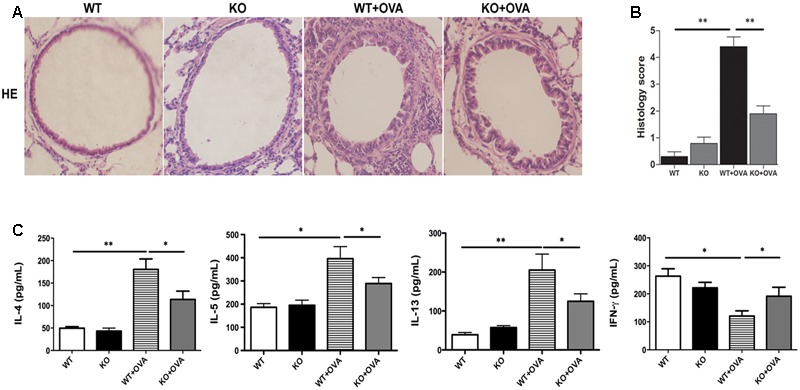
Gene deletion of KCa3.1 reduced established airway inflammation. (A) Representative images of hematoxylin and eosin-stained lung sections from WT, KO, WT + OVA, and KO + OVA groups (original magnification, X30). (B) Quantitative analyses of inflammatory cell infiltration in lung sections. Data were expressed as means ± SEM (n = 5). ∗∗p < 0.01, one-way ANOVA followed by the Dunnett’s multiple comparison test compared with WT + OVA mice. (C) Effects of KCa3.1 deficiency on BAL fluid cytokine concentrations in a mouse model of chronic asthma. BAL fluid cytokine concentrations from WT, KO, WT + OVA, and KO + OVA groups. Concentrations of IL-4, IL-5, IL-13, and IFN-γ were analyzed using ELISA. Values were shown as means ± SEM (n = 6). ∗p < 0.05, ∗∗p < 0.01, one-way ANOVA followed by the Dunnett’s multiple comparison test compared with WT + OVA mice. WT, wildtype; KO, knockout.